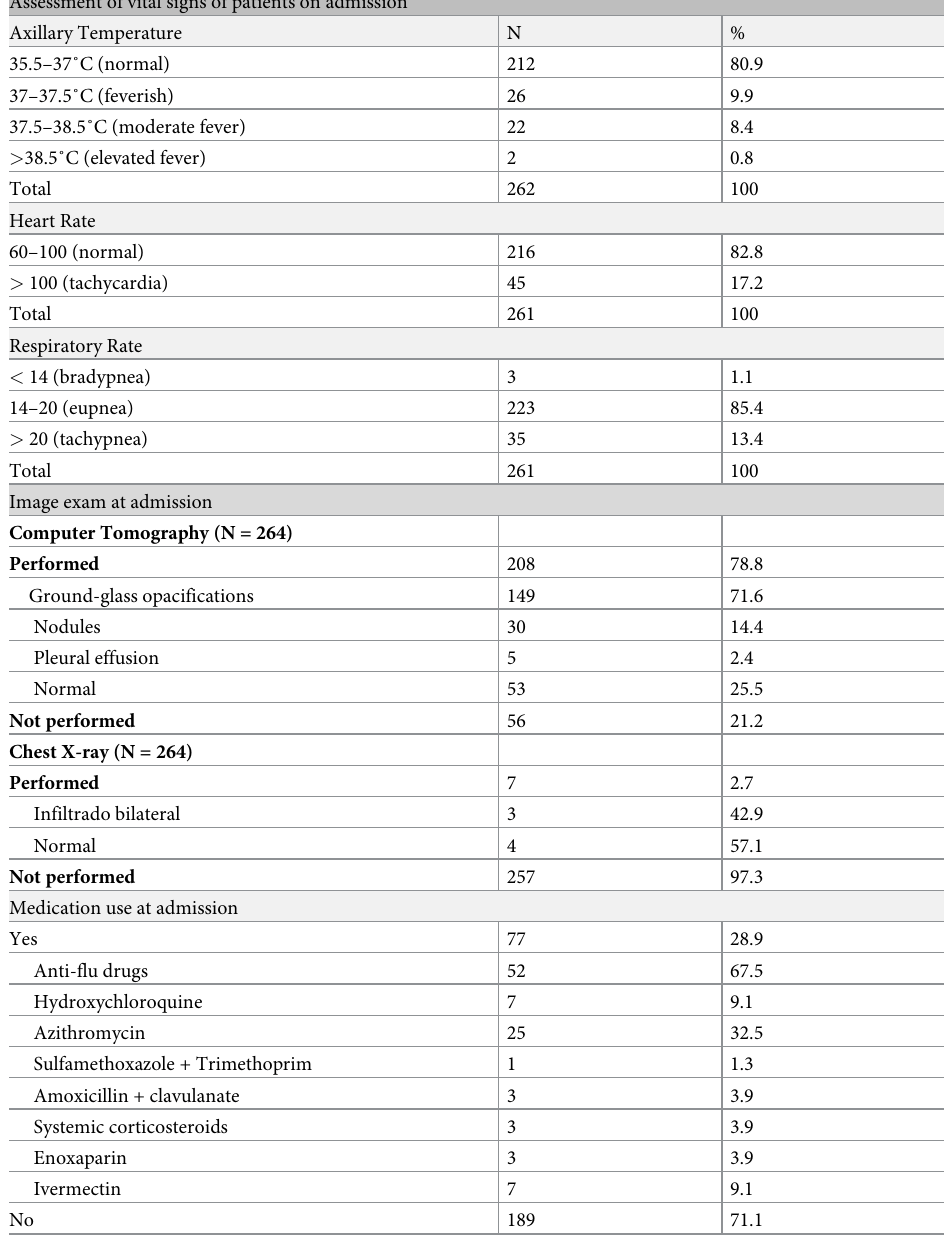
Table 2. Physical and initial examination of the patient on admission to the emergency